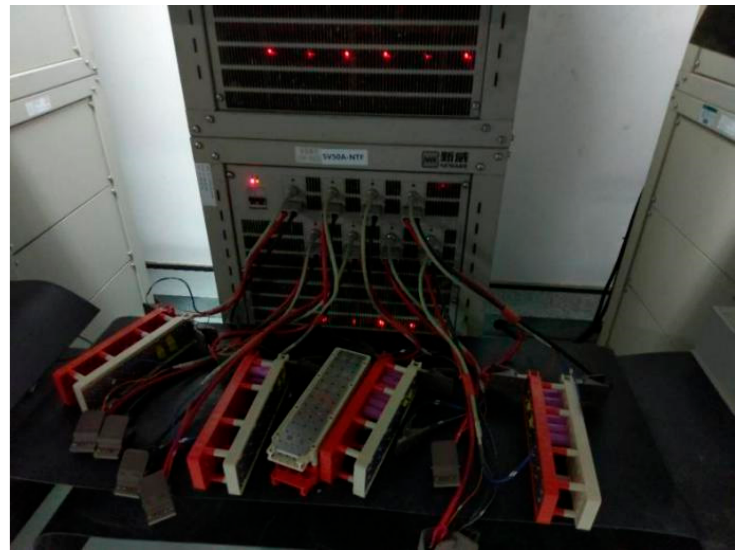
Figure 11. Topology diagram of the experimental battery system.